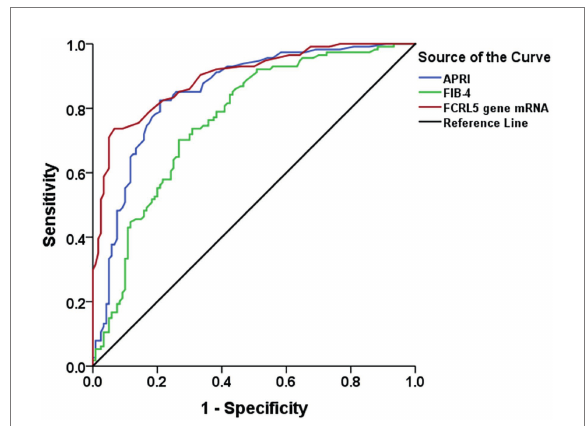
FIGURE 3 ROC curve of the FCRL5 mRNA expression, APRI and FIB-4 index for predicting liver fibrosis in CHB patients. FCRL5, Fc receptor- like 5; ROC, receiver operator